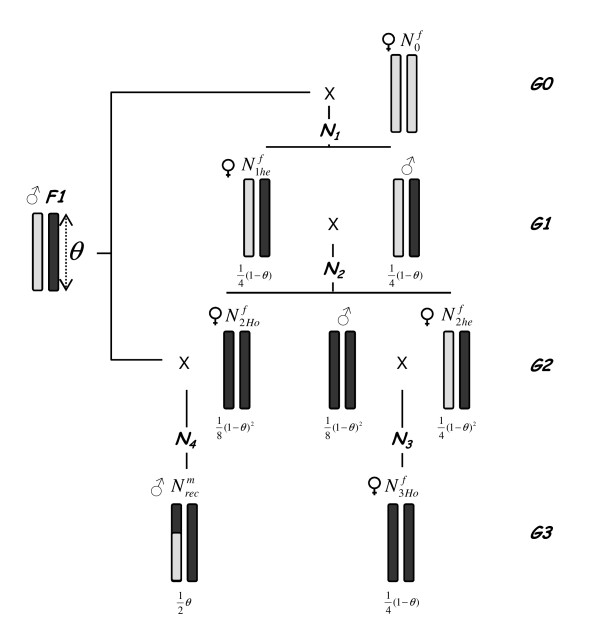
Strategy to fine map a QTL located initially in θ cM segment S. The black segments show Meishan origin, the grey segments Large White origin. All the MS segments have a common origin, LW chromosome are unrelated. The number of individuals in each sample N** (and the probability to obtain them depending on θ are indicated.